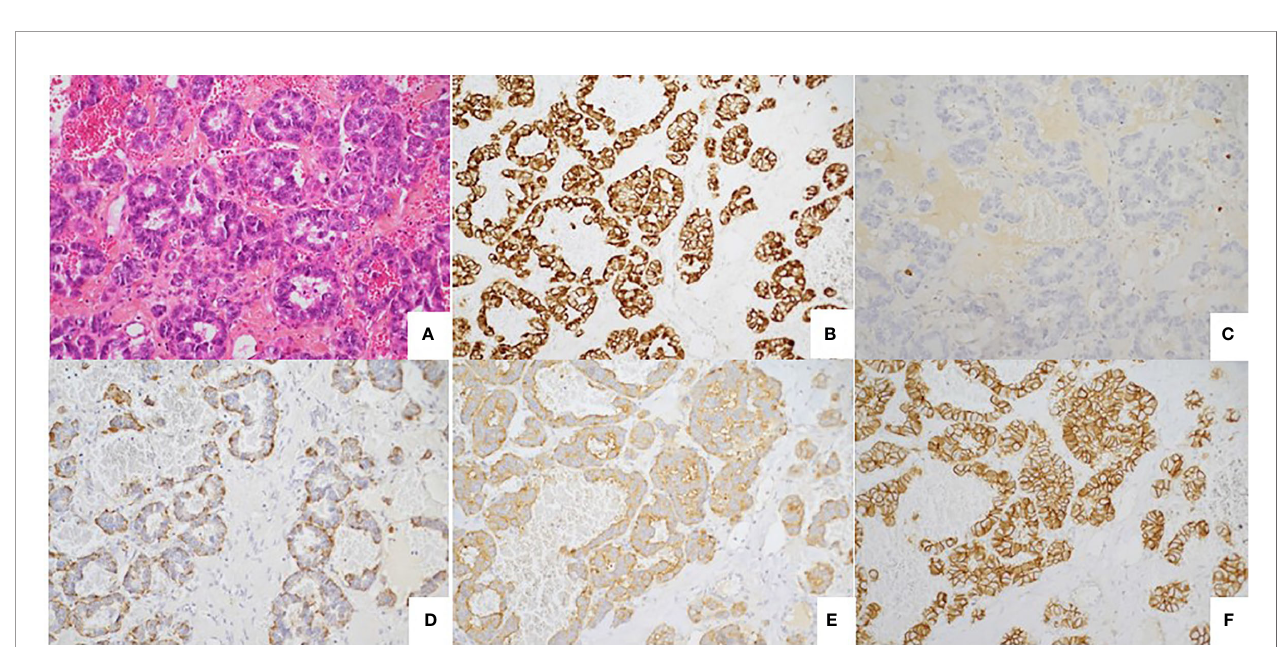
FIGURE 4 | Well differentiated tumor. (A) Well-differentiated neuroendocrine tumour with glandular architecture. HES, x 20. (B) Immunostaining CKAE1/AE3, monoclonal antibody, clone AE1/AE3/PCK26, Ventana, x20. (C) Immunostaining KI67: low nuclear expression (< 1%) monoclonal antibody, clone MIB1, Agilent Dako, x20. (D) Immunostaining Chromogranin A, monoclonal antibody, clone LK2H10, Ventana, X20. (E) Immunostaining Synaptophysin, monoclonal antibody, clone SP11, Ventana, X20. (F) Immunostaining CD56, monoclonal antibody, clone MRQ-42, Ventana/Cell marque,